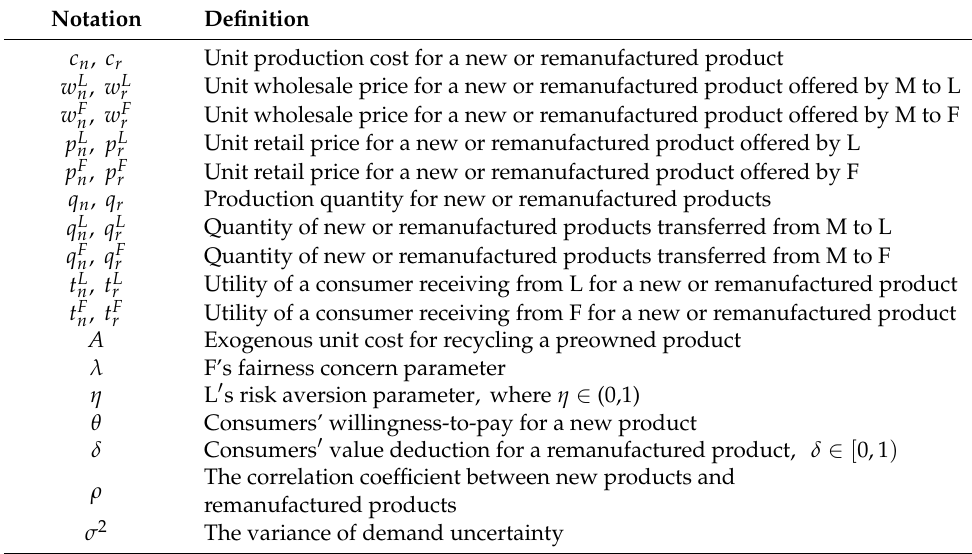
Table 2. Variables and parameters.